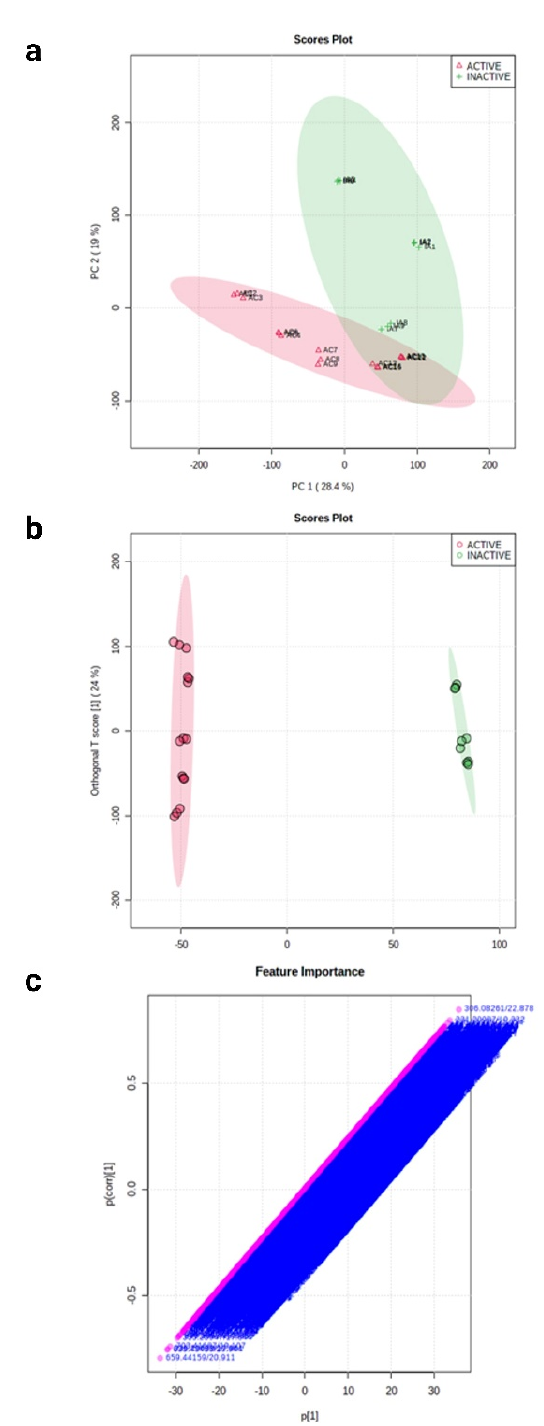
Figure 3. Comparative metabolomics of F15-16 cytotoxic active and inactive fractions. ( a ) PCA scores plot for F15-16 subfractions. ( b ) OPLS-DA scores plot of all of the metabolite features of F15-16 subfractions. ( c ) PLS-DA loadings S-plot for F15-16 subfractions showing the variable importance in a model, combining the covariance and the correlation (p(corr)) loading profile.